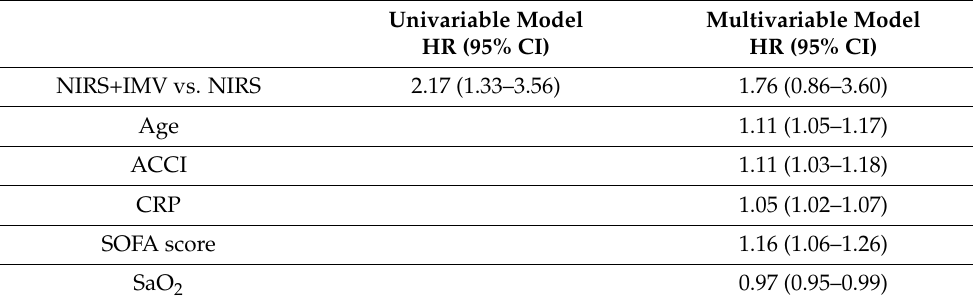
Figure 2. Simon and Makuch’s survival curves stratified by treatment. Table 3. Hazard ratios (HRs) for the association between ventilatory treatment and the risk of 90-day mortality according to univariable and multivariable Cox proportional hazard